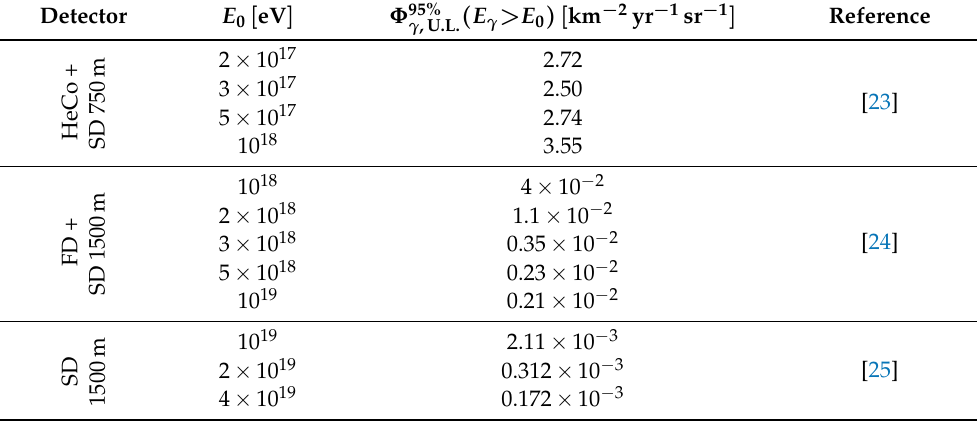
Figure 6. Current upper limits on the integral photon flux determined from data collected by the Pierre Auger Observatory (red, blue and gray circles). We also show the upper limits published by other experiments: KASCADE-Grande (orange crosses) [34], EAS-MSU (magenta triangles) [35]) and Telescope Array (green squares from [36] and turquoise squares from [37]). The ranges of expected GZK photon fluxes under the assumption of two different pure-proton scenarios are shown as the red and gray bands (following [2] and [5], respectively). The green band shows the expected GZK photon flux, assuming a mixed composition that would fit the Auger data [3], while the blue band denotes the range of photon fluxes that would be expected from cosmic-ray interactions with matter in the Milky Way [4]. In addition, the expected photon fluxes from the decay of super-heavy dark matter particles are included (decay into hadrons, X → q ¯ q , based on [38]: dashed violet line for a mass of the SHDM particles M X = 10 10 GeV and a lifetime τ X = 3 × 10 21 yr [SHDM Ia]; brown dot-dashed line for M X = 10 12 GeV and τ X = 10 23 yr [SHDM Ib]; decay into leptons, X → ν ¯ ν , based on [39]: dashed gray line for M X = 10 10 GeV and τ X = 3 × 10 21 yr [SHDM II]; the exact lines have been obtained through personal communication with one of the authors). Table 1. Compilation of the upper limits on the integral photon flux determined through the three analyses discussed in the previous